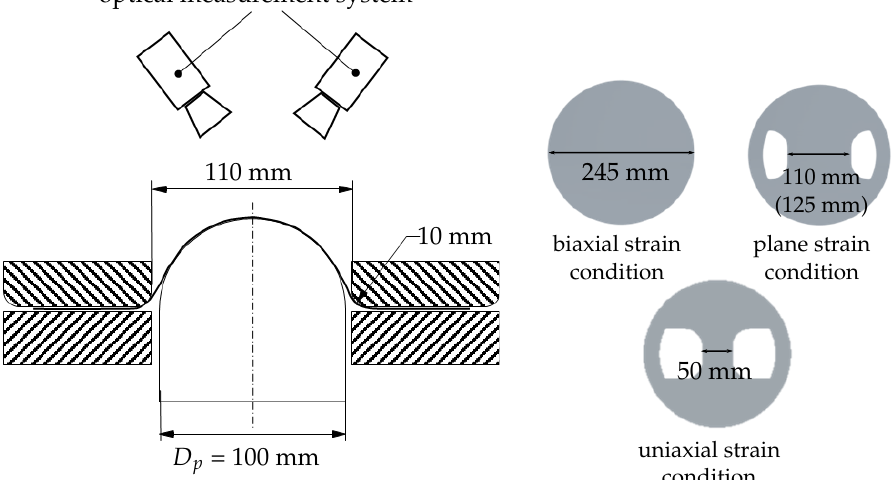
Figure 1. Schematic drawing of the used Nakajima setup and main geometries of